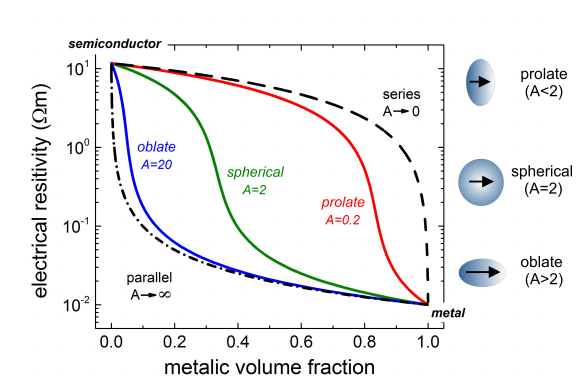
Figure 5. The effective electrical resistivity determined from Equation (1), according to the generalized Bruggeman theory for composite metal-semiconductor media with different values of the geometrical factor A, i.e., 2 for spherical, 0.2 for prolate and 20 for oblate inclusions. The curves corresponding to parallel and series resistors are also shown.